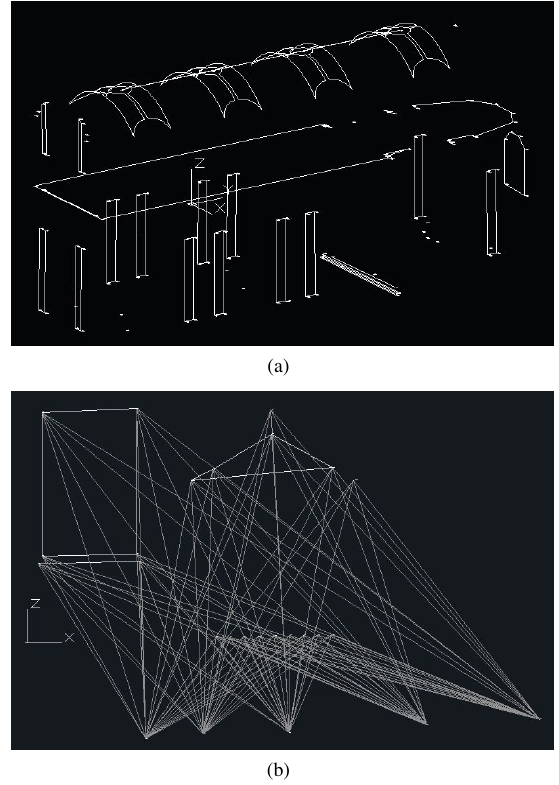
Figure 5. Wireframe drawing of San Francesco (a) and Santa Maria della Piazza (b), plotted by using Spherical Photogramme- try.